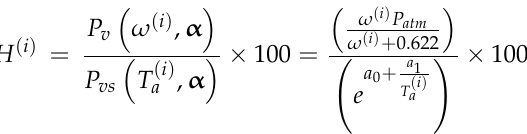
Figure 4. Bar plot of the water mass flow rates m ( ) i along the height of the fill section of the cooling tower.